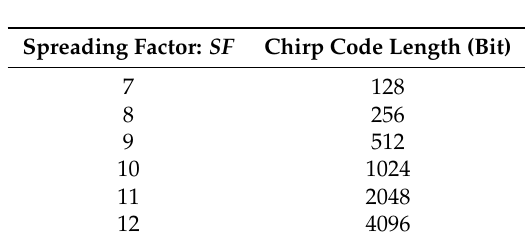
Table 2. Chirp code